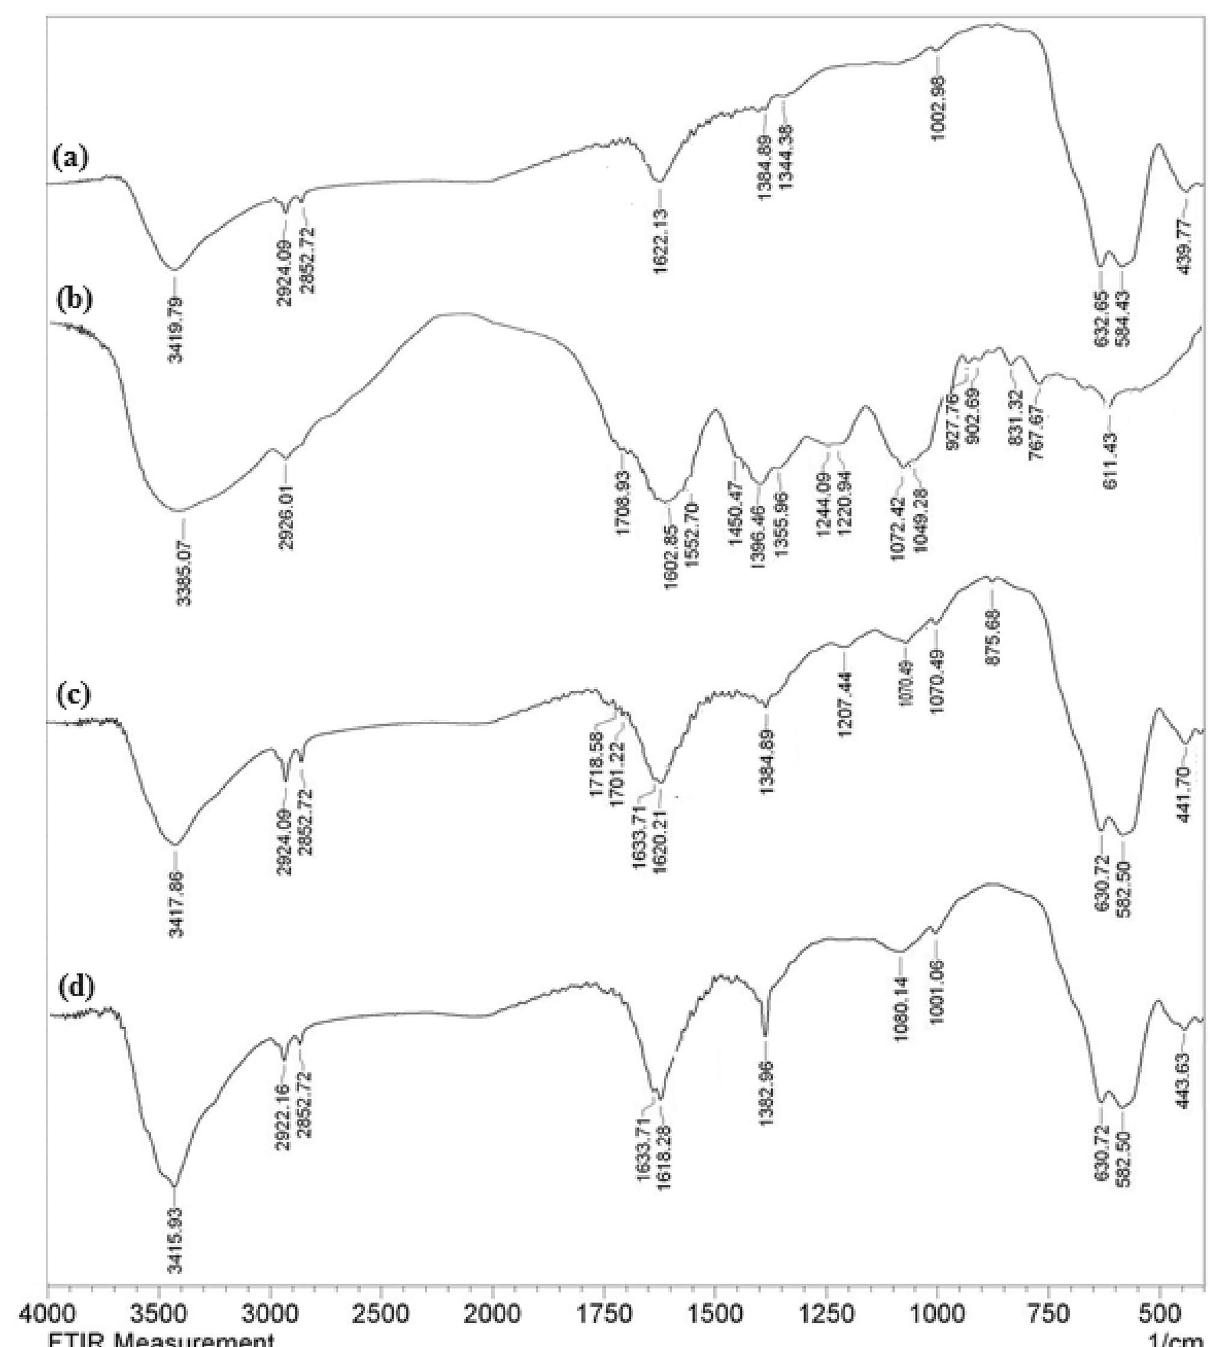
Figure 2. FT-IR spectrum of ( a ) Fe 3 O 4 , ( b ) Fritillaria extract, ( c ) Fe 3 O 4 @ Fritillaria NPs, and ( d )